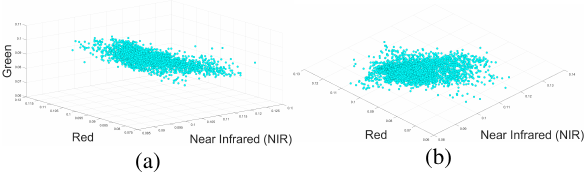
Figure 11. Buildings-streets superpixels in feature space.